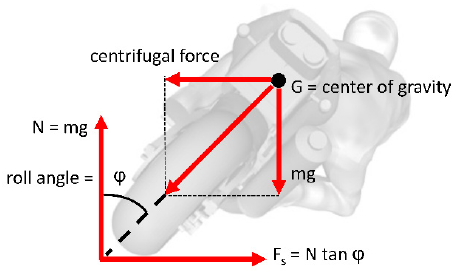
Figure 3. PTW lateral equilibrium during curvilinear trajectory.